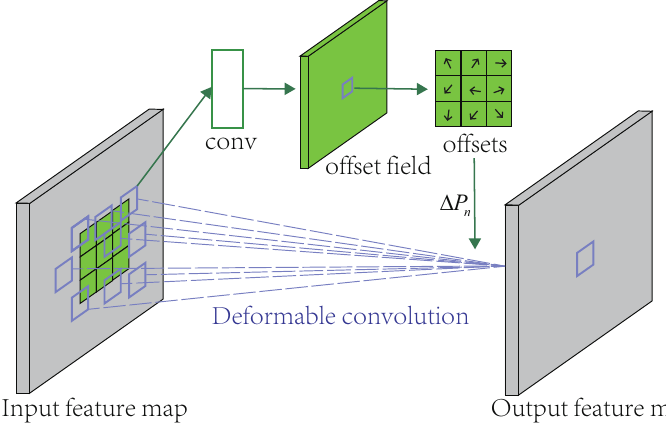
Figure 6. Illustration of a 3 × 3 deformable